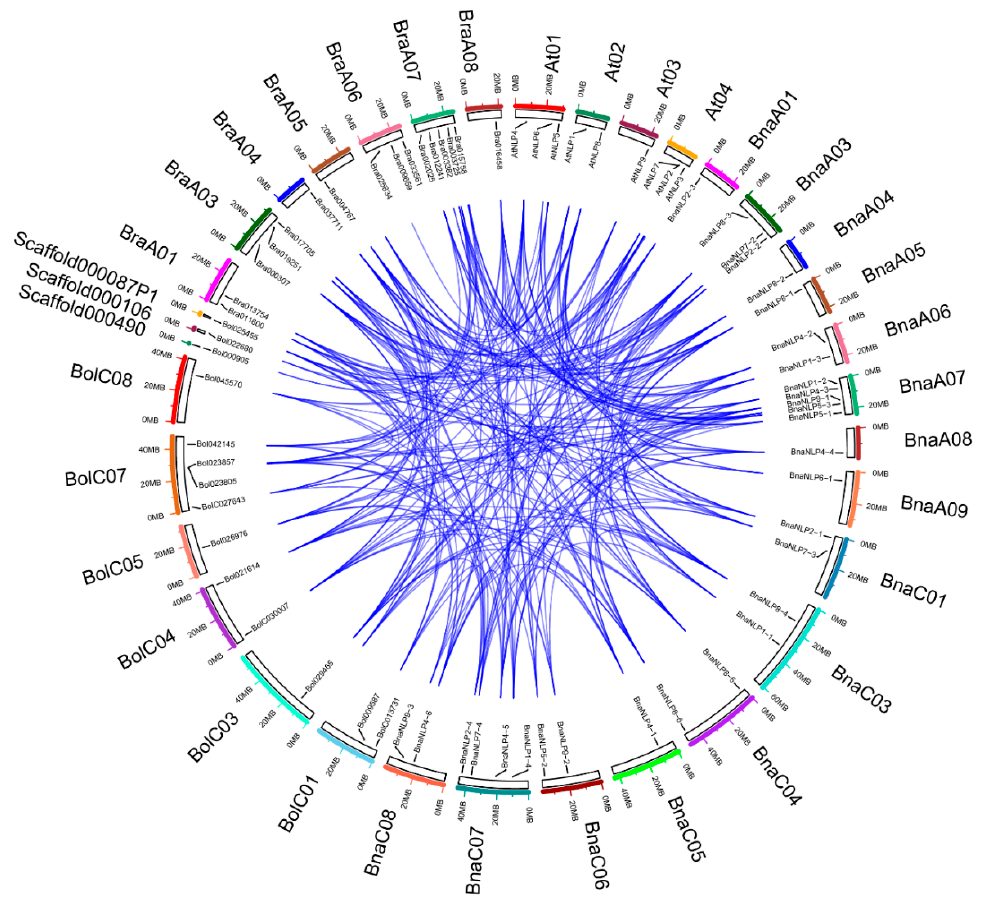
Figure 4. Syntenic relationships of NLP genes in A. thaliana , B. napus , B. rapa , and B. oleracea .